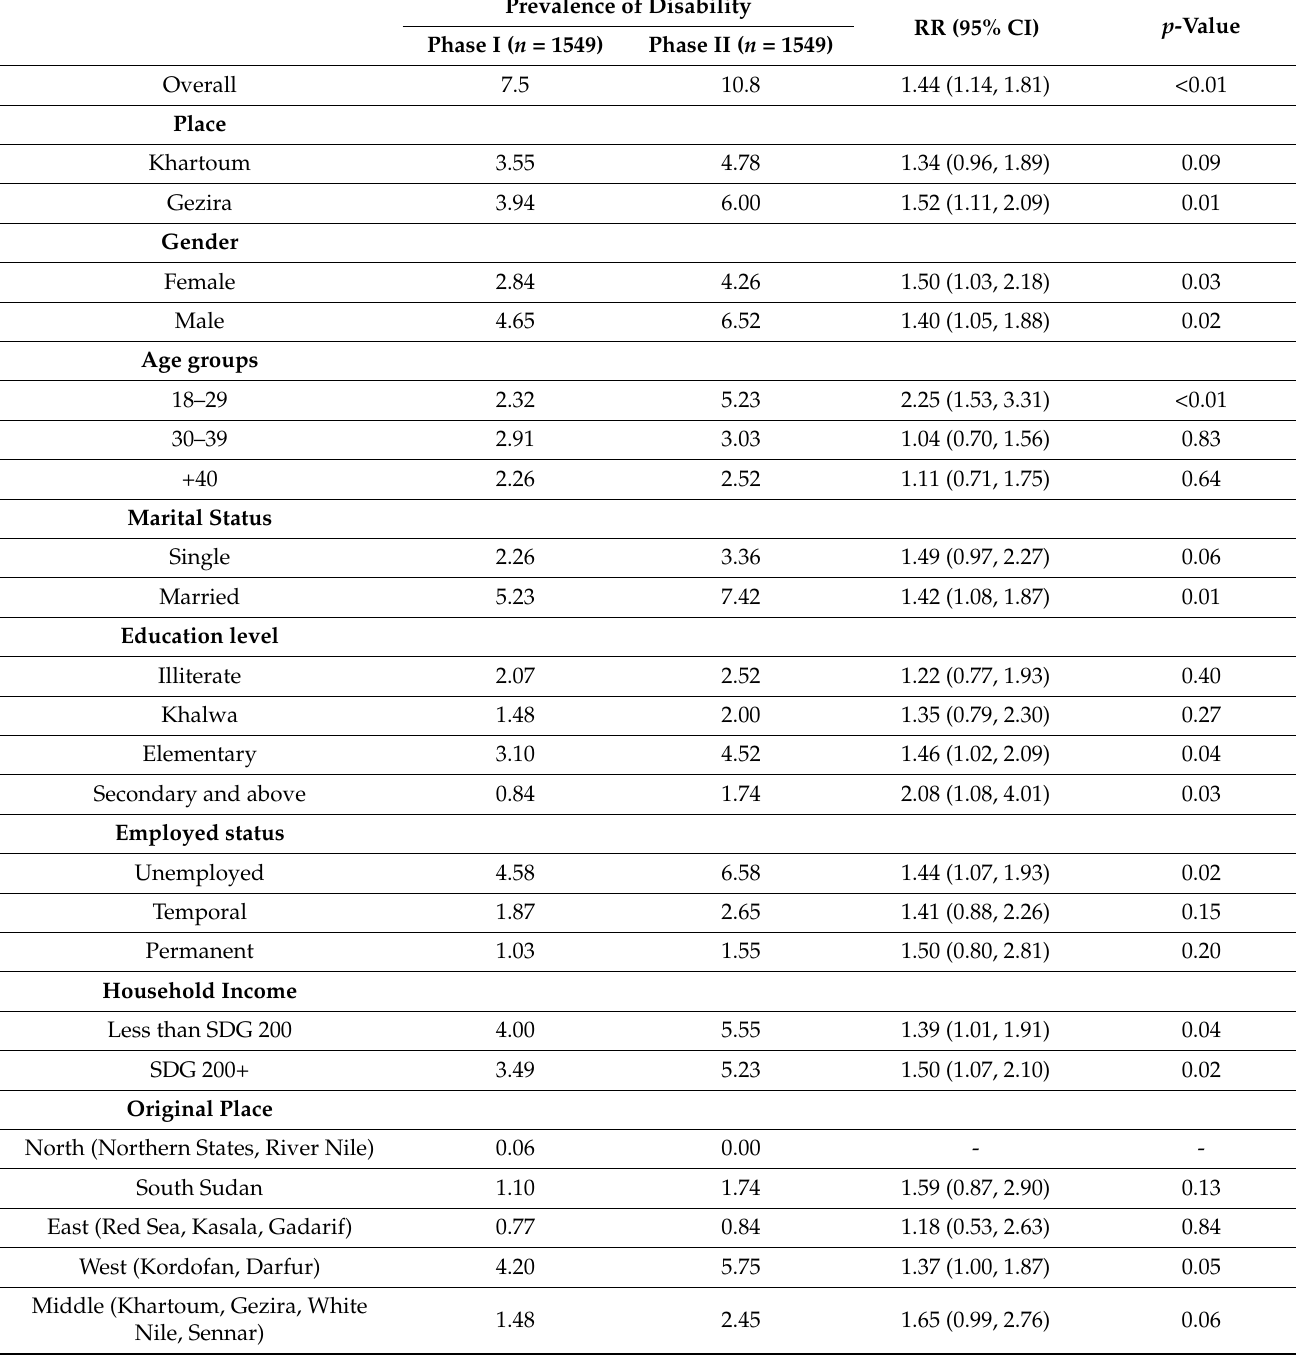
Table 3. The prevalence and risk (RR) of disability by sociodemographic factors with phase 1 as